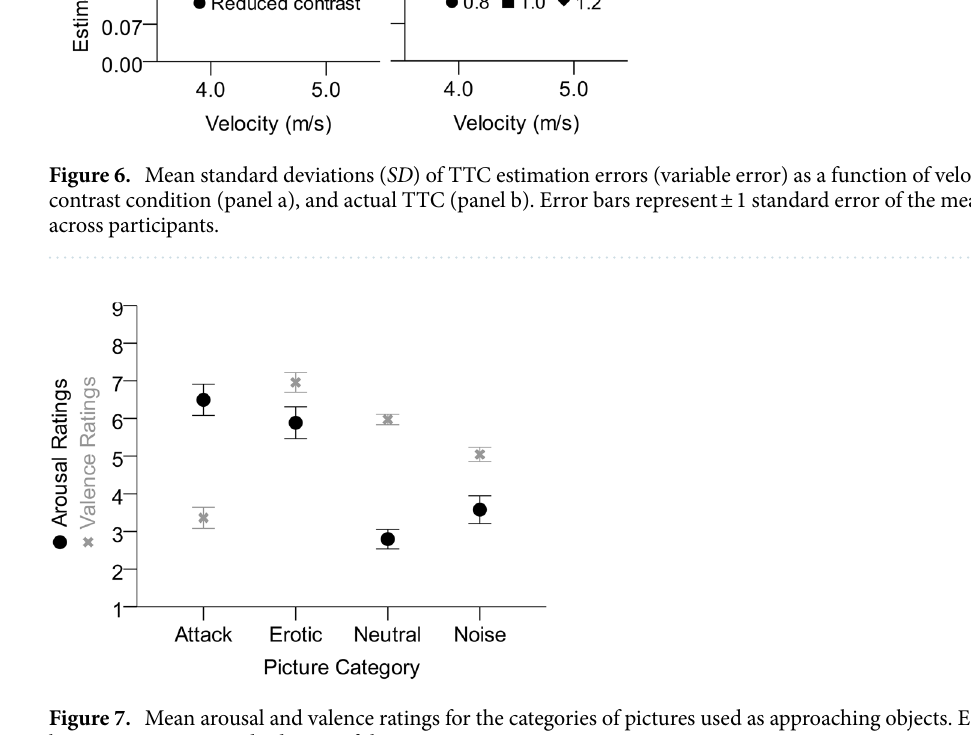
Figure 7. Mean arousal and valence ratings for the categories of pictures used as approaching objects. Error bars represent ± 1 standard error of the mean across